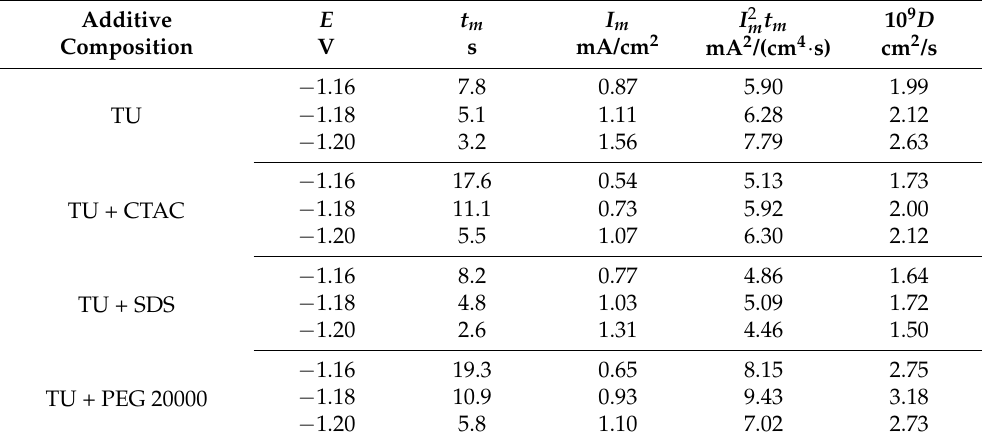
Table 2. Maximum transient current, time to reach and the diffusion coefficient for different potentials and composite